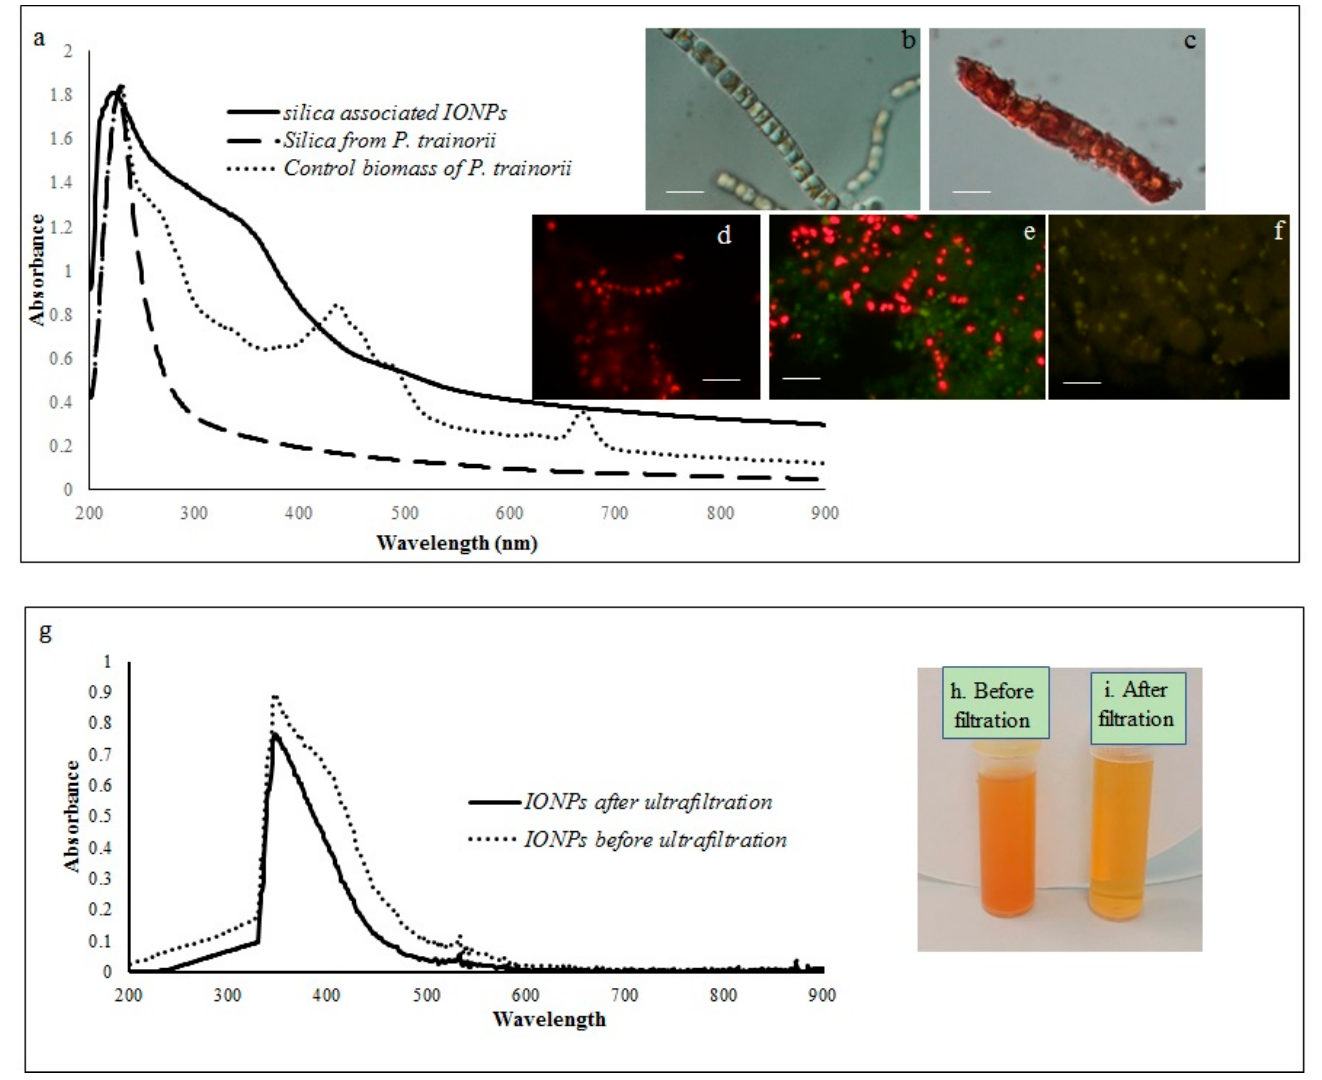
Figure 1. Showing UV-Vis spectroscopy of control biomass, cleaned frustules and IONP-loaded frustules ( a ). LM images of P. trainorii before ( b ) and after ( c ) treatment with Fe 3 + solution [scale bar 1 μ m]. Fluorescent images control ( d ) and Fe 3 + exposed P. trainorii taken at 24 h ( e ), 72 h ( f ) of reaction [scale bar 1 μ m]. UV-Vis spectroscopy of extracellular IONPs before and after ultrafiltration ( g ). Extracellular IONPs suspension before ( h ) and after ( i ) ultrafiltration.